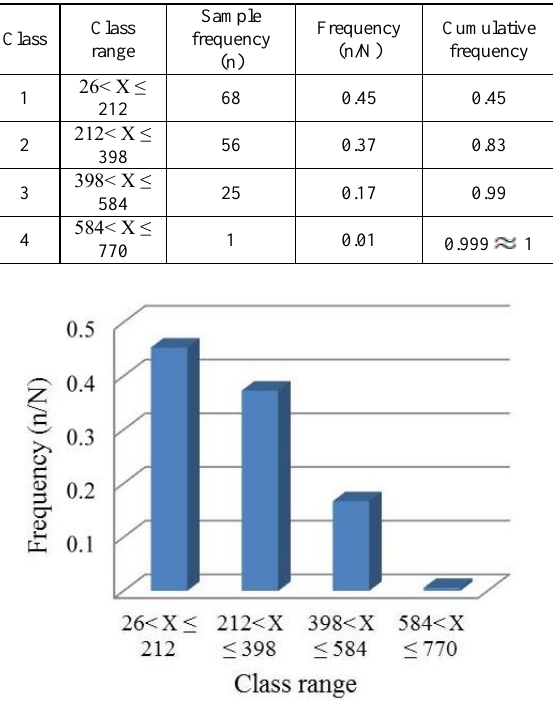
Figure 3. Distribution of BOD